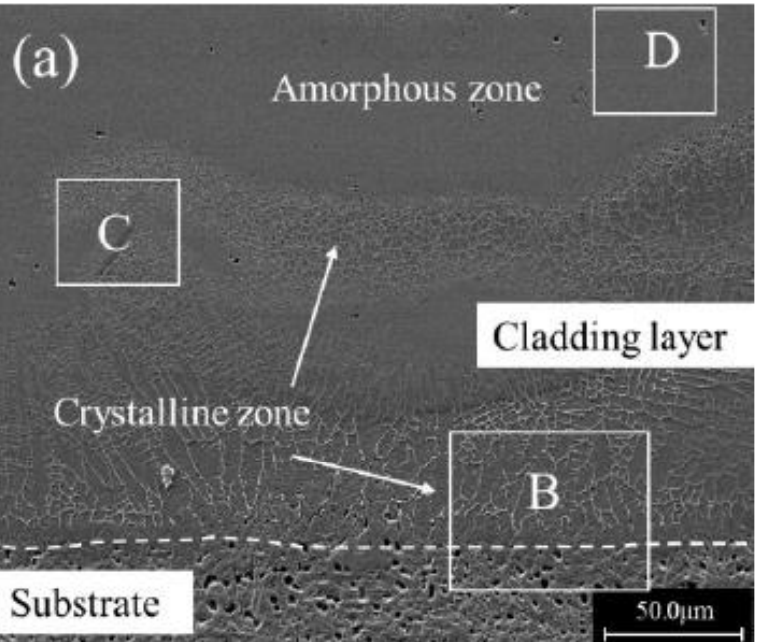
Figure 15. Cross-sectional micrograph of a single bead clad specimen during LC of (FeMoCrCoCBYSi) coating on 3Cr13 stainless steel substrates showing crystalline and amorphous regions during LC. Reproduced with permission from [83]. Copyright MDPI, 2019.